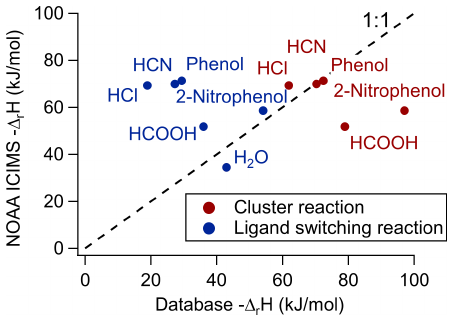
Figure 5. NOAA-CIMS-measured reaction enthalpies vs. the NIST WebBook database reaction enthalpies for either the direct- clustering pathway or ligand-switching pathway. A one-to-one line is included to indicate where the measured reaction enthalpy agrees with the database.